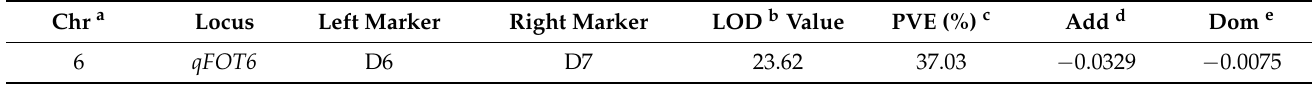
Table 1. Identification of qFOT6 using composite interval mapping in F 2 .